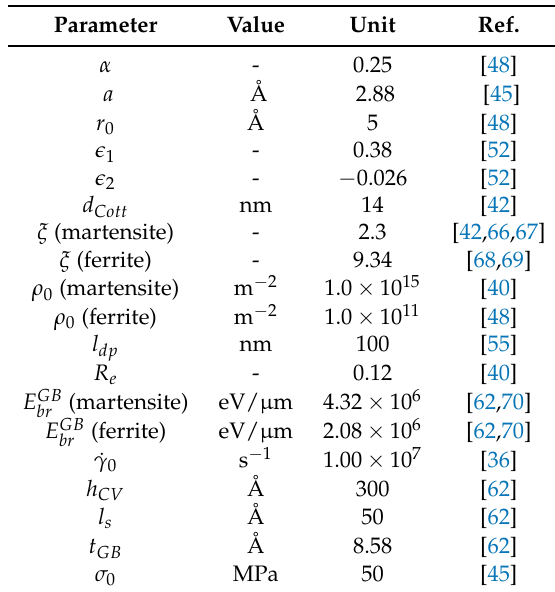
Table 1. Parameters for prediction.